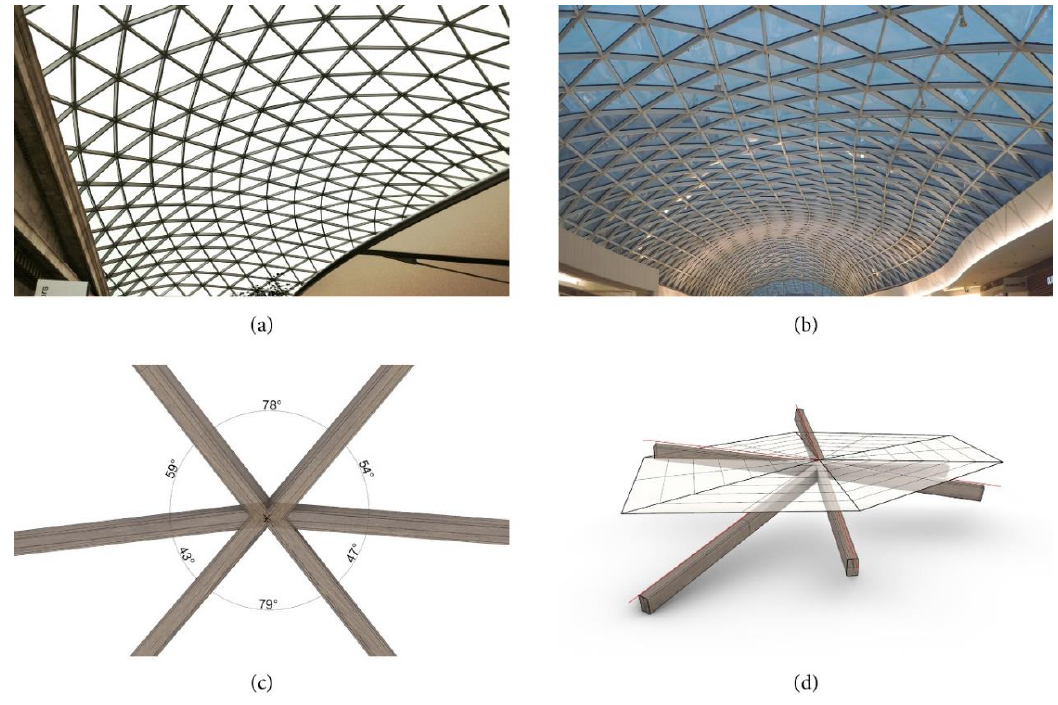
Figure 1. ( a ) British Museum Great Courtyard roof in London; ( b ) Eurovea Shopping Centre in Bratislava; ( c , d ) varying angles in space between the individual frame members that have to be considered for the design and production of the knot.